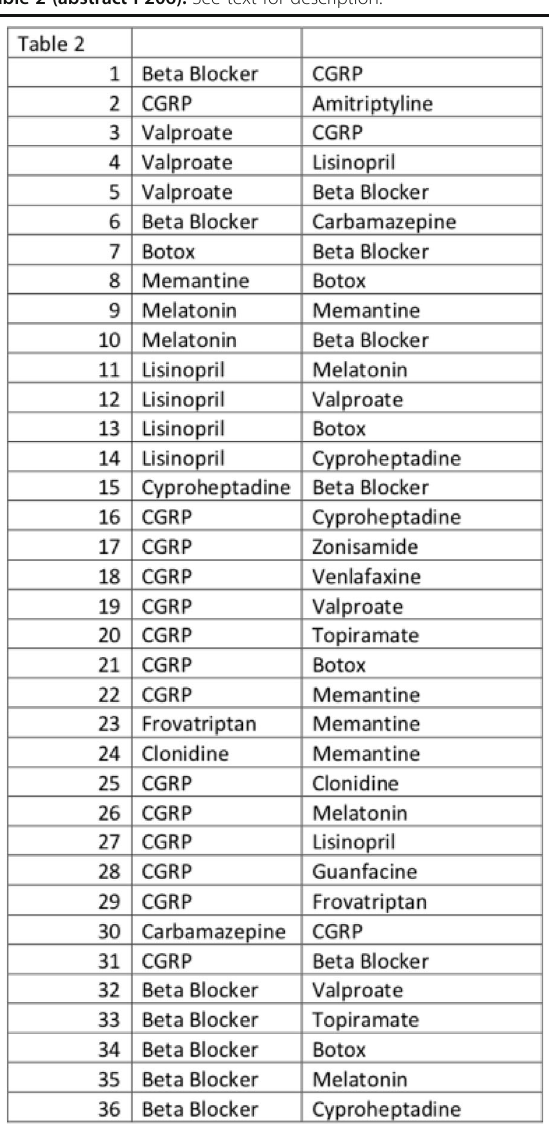
Table 2 (abstract P206). See text for